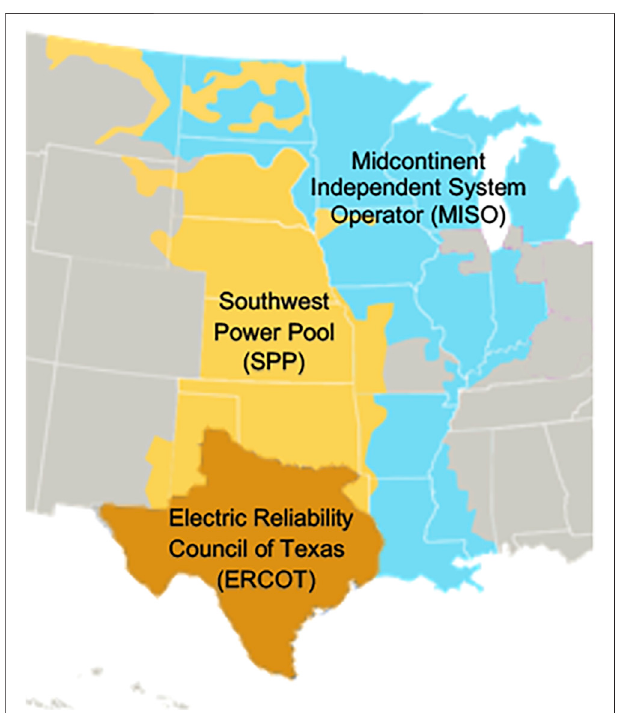
FIGURE 2 | Areas affected by this